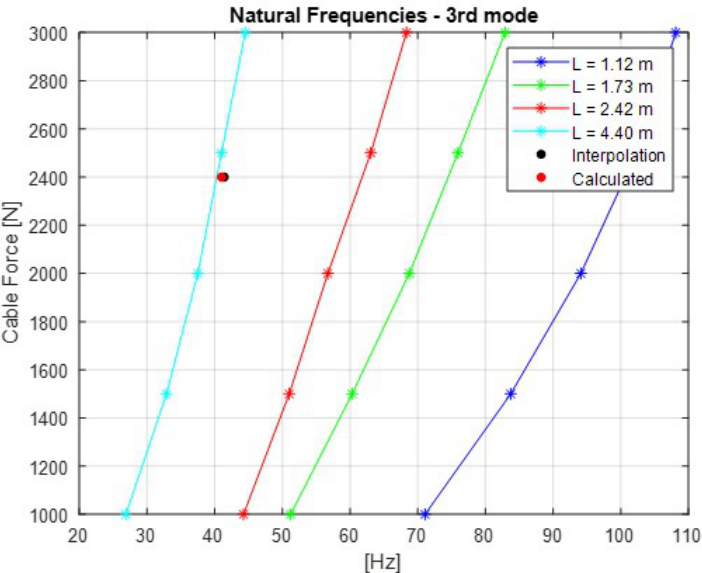
Figure 9. Relationship between the cable force and natural frequencies for the third mode of